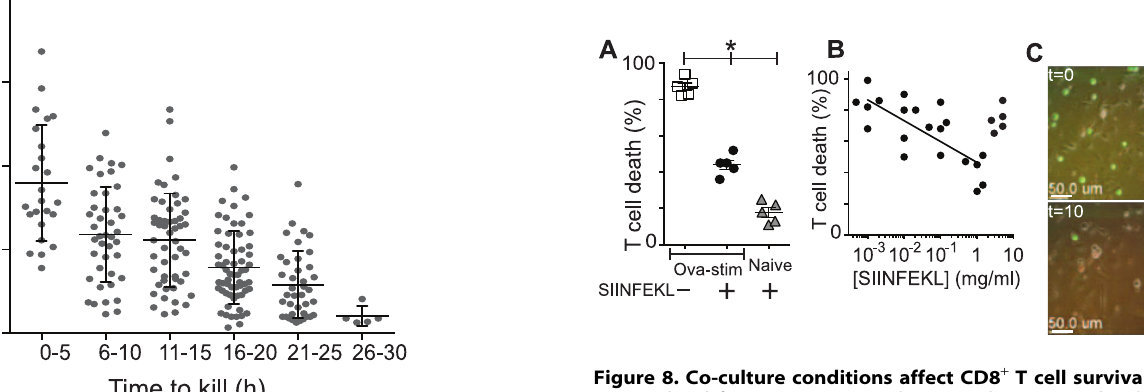
Figure 8. Co-culture conditions affect CD8 + T cell survival. CTL were isolated from OVA-immunised mice and were stimulated for a short time in vitro before adding to KC monolayers loaded with SIINFEKL and imaging for 20 hours. CTL death was determined by size ( , 10 m m), colour change (EGFP to red indicating loss of EGFP expression and caspase-3 activation) and morphology. A . T cell death in response to KC targets with 1 mg.ml 2 1 SIINFEKL and without peptide. (N=5, error bars SEM, *p , 0.05 between indicated groups) B . T cells were added to KCs loaded with increasing concentrations of SIINFEKL and CTL death over 30 hours was measured. (N=5) C . CTL were added to KC monolayers loaded with 10 mg.ml 2 1 SIINFEKL. Still images from the beginning of co-culture (upper panel) and at 10 hours (lower panel) were taken by epifluorescent time-lapse microscopy.